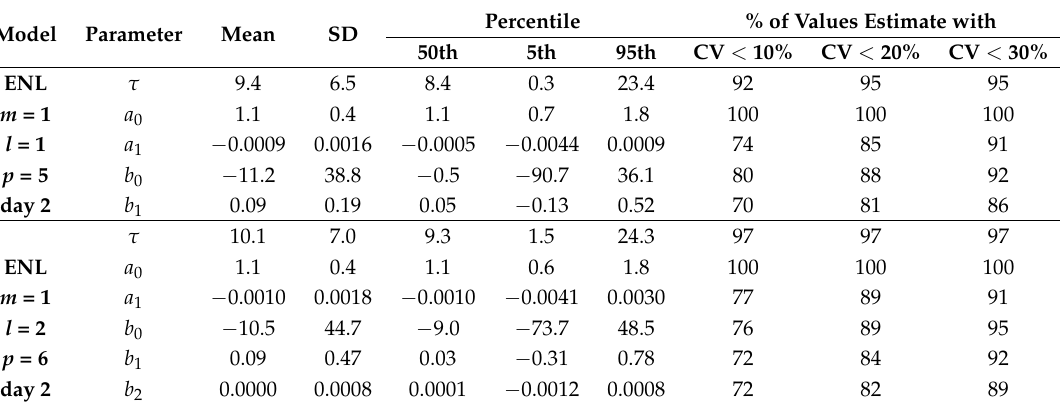
Table 2. Mean, standard deviation, 50th, 5th, and 95th percentile values for parameters generated considering models of order m = l = 1 and m = 1, l = 2 and percentage of values estimated with a coefficient of variation lower than 10%, 20% and 30% for the second generation Medtronic Paradigm Veo Enlite (ENL) sensor.